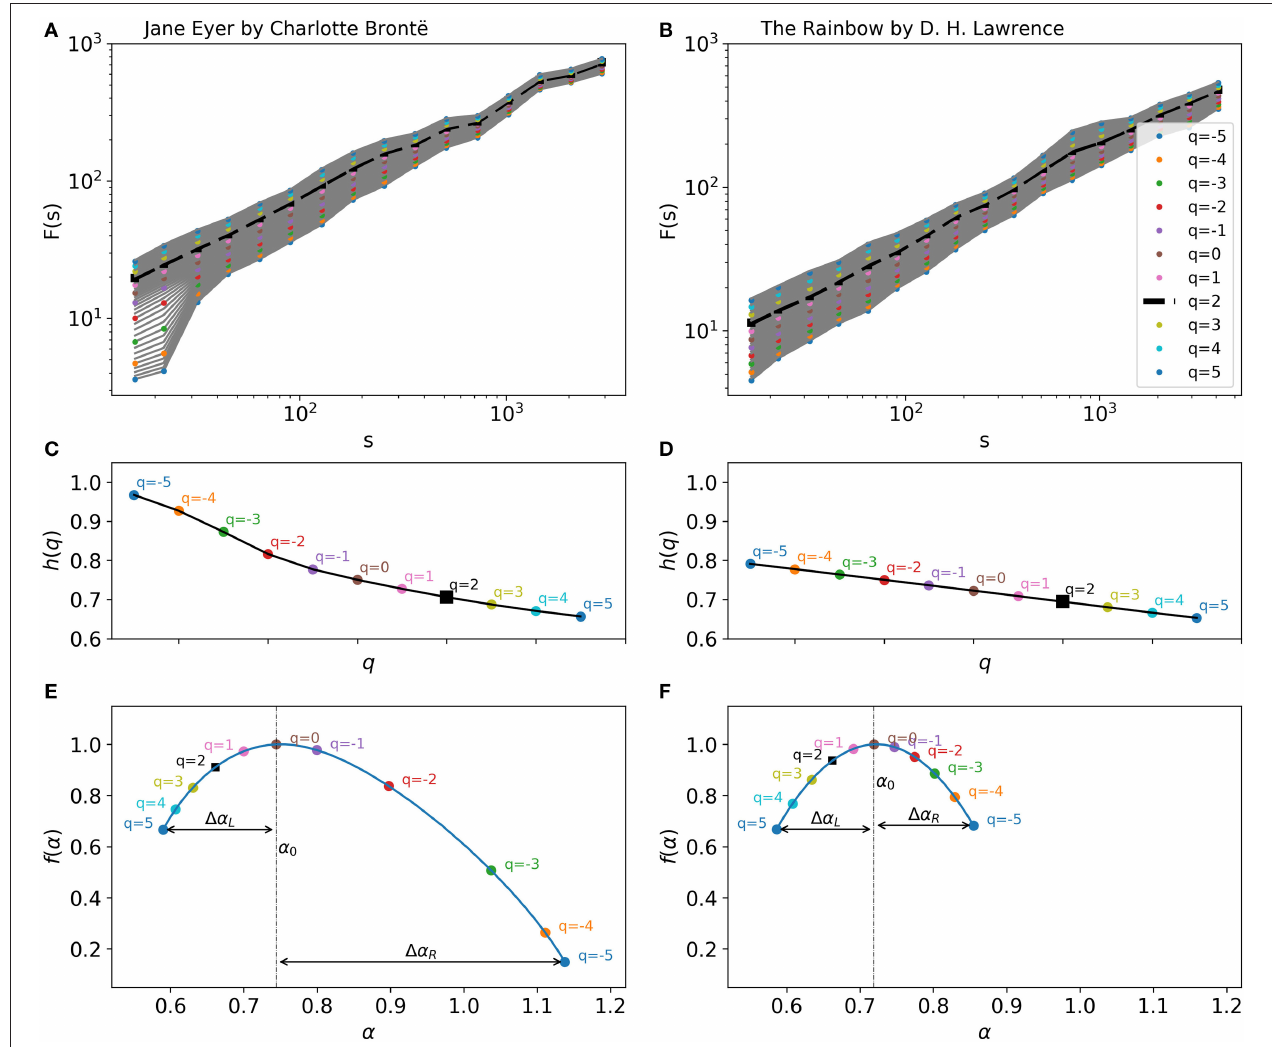
FIGURE 2 | (A,B) q th order of mean square fluctuation of sentence-length series of Jane Eyre by Charlotte Brontë (A) and The Rainbow by D. H. Lawrence (B) . The plots show F q ( s ) for different scales of s and for different values of q , ranging from − 5 to 5 in steps of 0.25. The colored points represent values that correspond to the integer q s. H is the slope of the best linear fit to the dashed curve, which corresponds to q = 2, and which identical to the output of the DFA method. (C,D) Slopes of the best linear fits to the fluctuation function in (A,B) , respectively. From these plots, singularity spectra are computed by the Legrand transformation. (E,F) Singularity spectra of the two texts. α 0 indicates the peak of each curve. The width of the curve, 1α = 1α L + 1α R , known as the degree of multifractality ( D ), shows how multifractal a series is. Here, both texts are highly multifractal. The fractal asymmetry ( A ) of the curve is calculated from 1α L and 1α R . The curve is asymmetrical for Jane Eyre , but symmetrical for The Rainbow